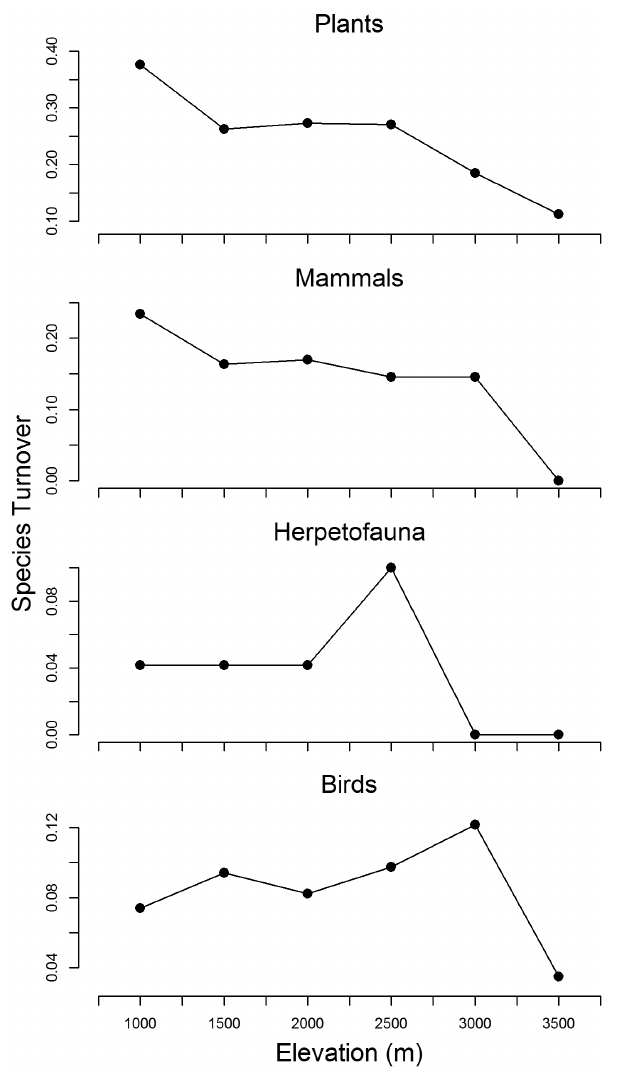
Figure 6. Estimated patterns of species turnover between elevation zones by taxonomic group. Values were calculated using the Sørensen dissimilarity index .